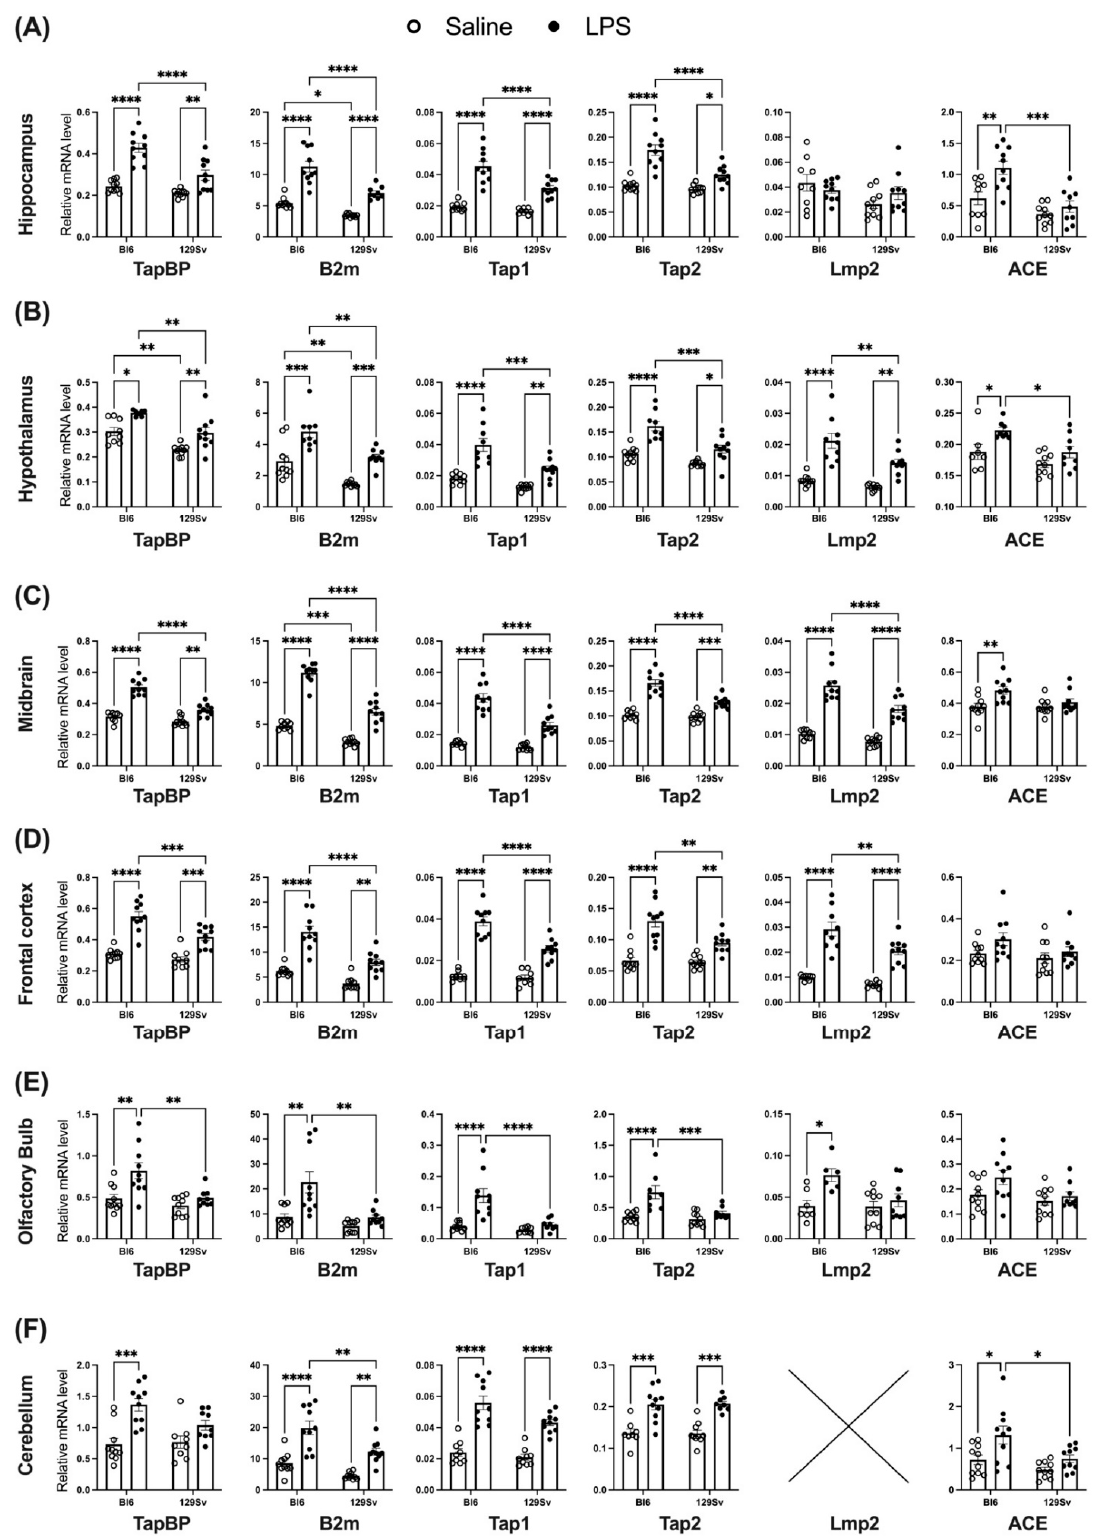
Figure 6. The mRNA expression of MHC-I-related genes in hippocampus ( A ), hypothalamus ( B ), midbrain ( C ), frontal cortex ( D ), olfactory bulb ( E ), and cerebellum ( F ): ×—no expression of Lmp2 was detected in the cerebellum. Data were analyzed by two-way ANOVA with Bonferroni post hoc test and presented as mean ± SEM: * p ≤ 0.05, ** p ≤ 0.01, *** p ≤ 0.001, **** p ≤